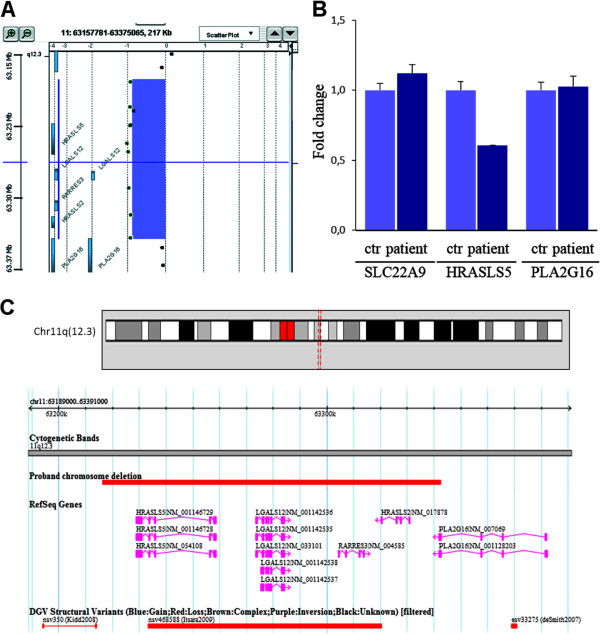
Identification of a de novo chromosome 11q12.3 deletion in MZ twins with Poland Syndrome. A) Array-CGH profile of chromosome 11 deleted segment. B) qPCR results for a region encompassed by the deletion (specific for the HRASLS5 gene), a 5′ flanking region (specific for SLC22A gene), and a 3′ flanking region (specific for PLA2G16 gene) obtained in the proband and one control individual. The copy number changes were calculated using the comparative DDCt method. Fold change of about 1 is expected for a diploid sample, and of about 0.5 for a haploid sample. C) Screenshot of chromosome 11 corresponding to the genomic position (chr11:63,216,306-63,342,369, NCBI build 37). Patient chromosome deletion (upper red bar), RefSeq genes, and Copy number variations (based on DGV, filtered to show only deletions) in the studied region.